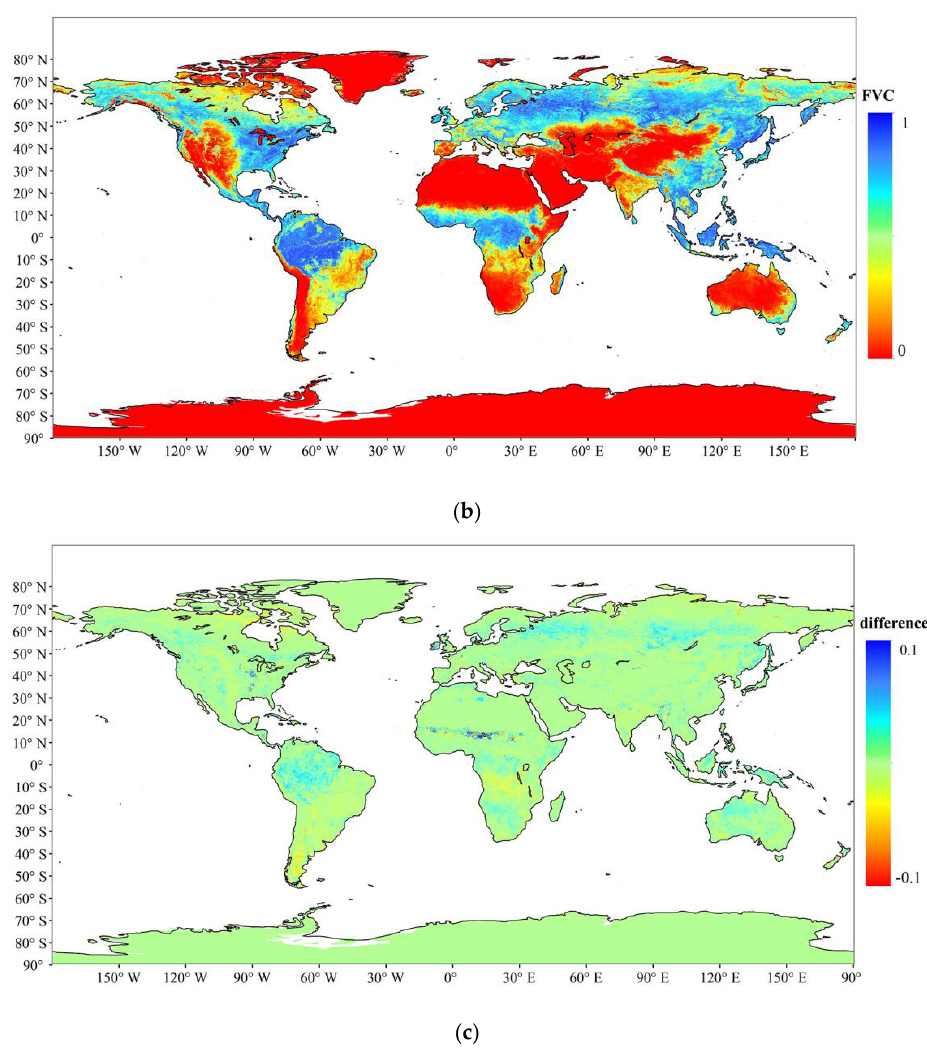
Figure 4. Global land surface FVC maps generated using the MARS and GRNN methods for day 201 (20 July) of 2003: ( a ) the MARS method; ( b ) the GRNNs method; ( c ) the global FVC difference map between the MARS and GRNNs methods.